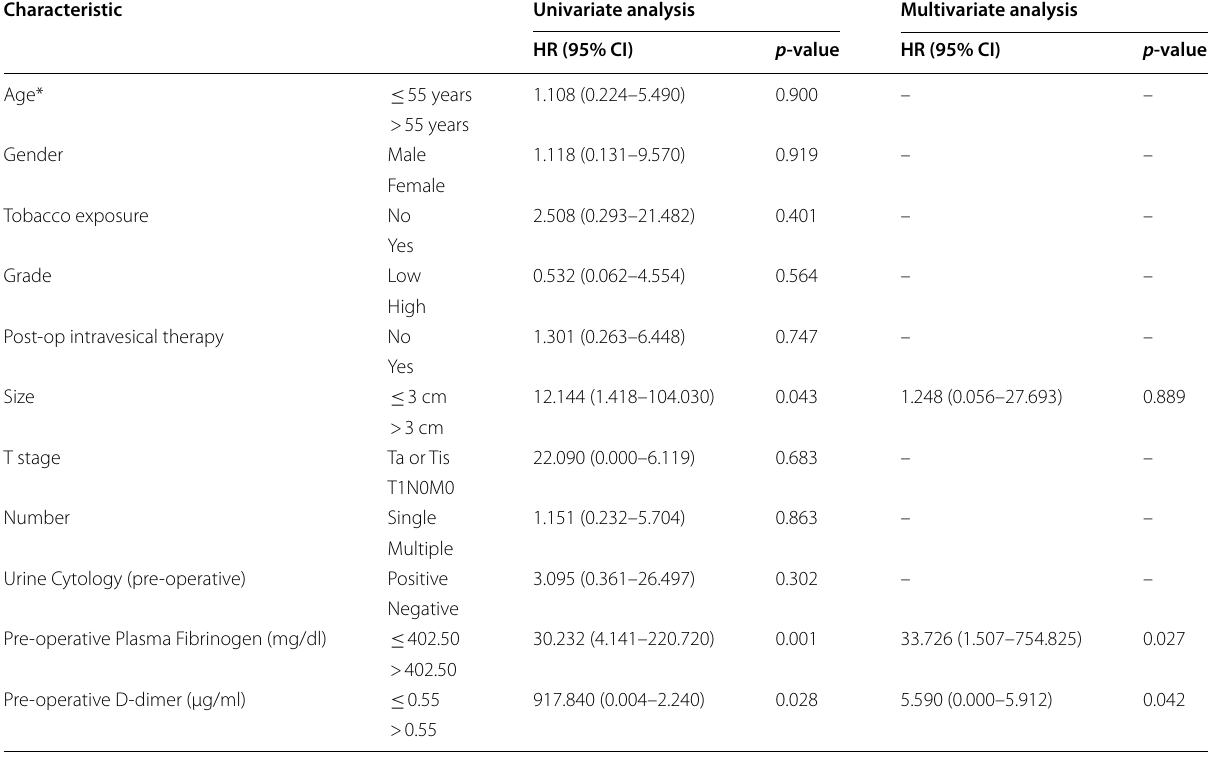
Table 4 Univariate and multivariate analyses of prognostic factors for disease progression by cox proportional hazards model